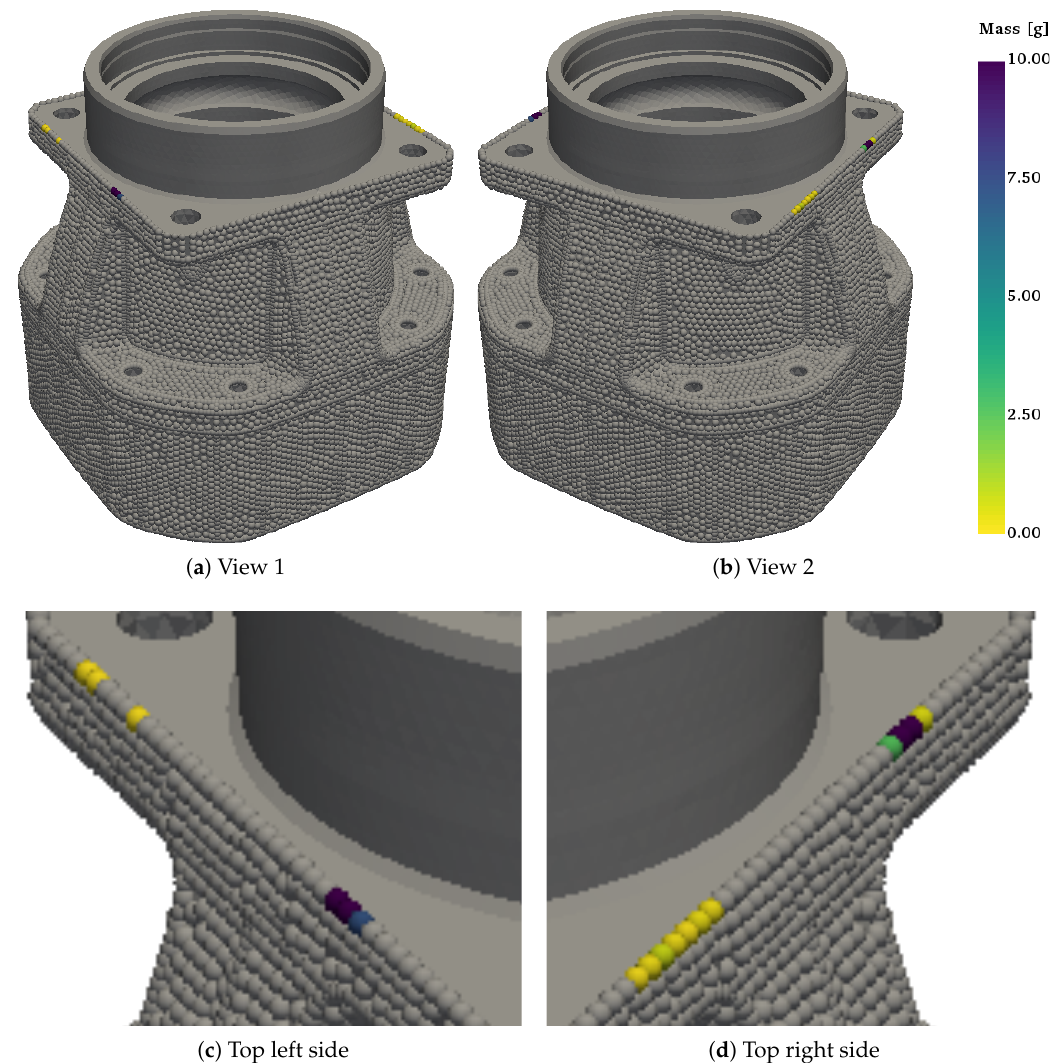
Figure 12. Values of design variables after optimization; nodes with zero mass are shown in gray, nodes with added mass are shown with the scale of the color